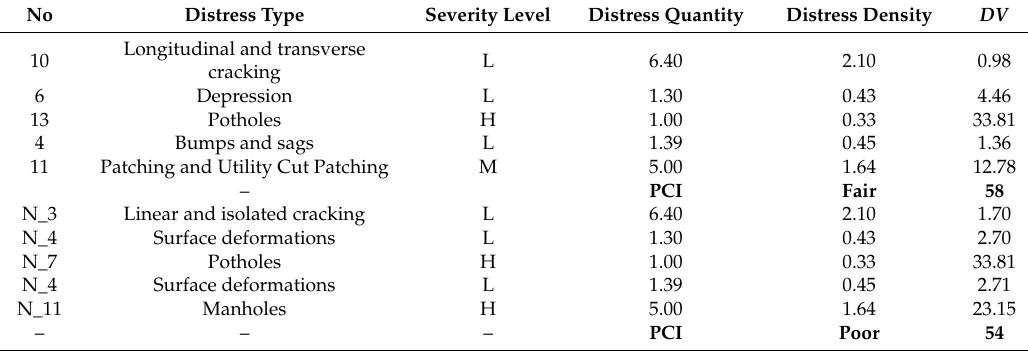
Table 9. Comparative analysis between ASTM D6433 and New Distress Identification Manual for Urban Pavements: N_12 Tree roots .